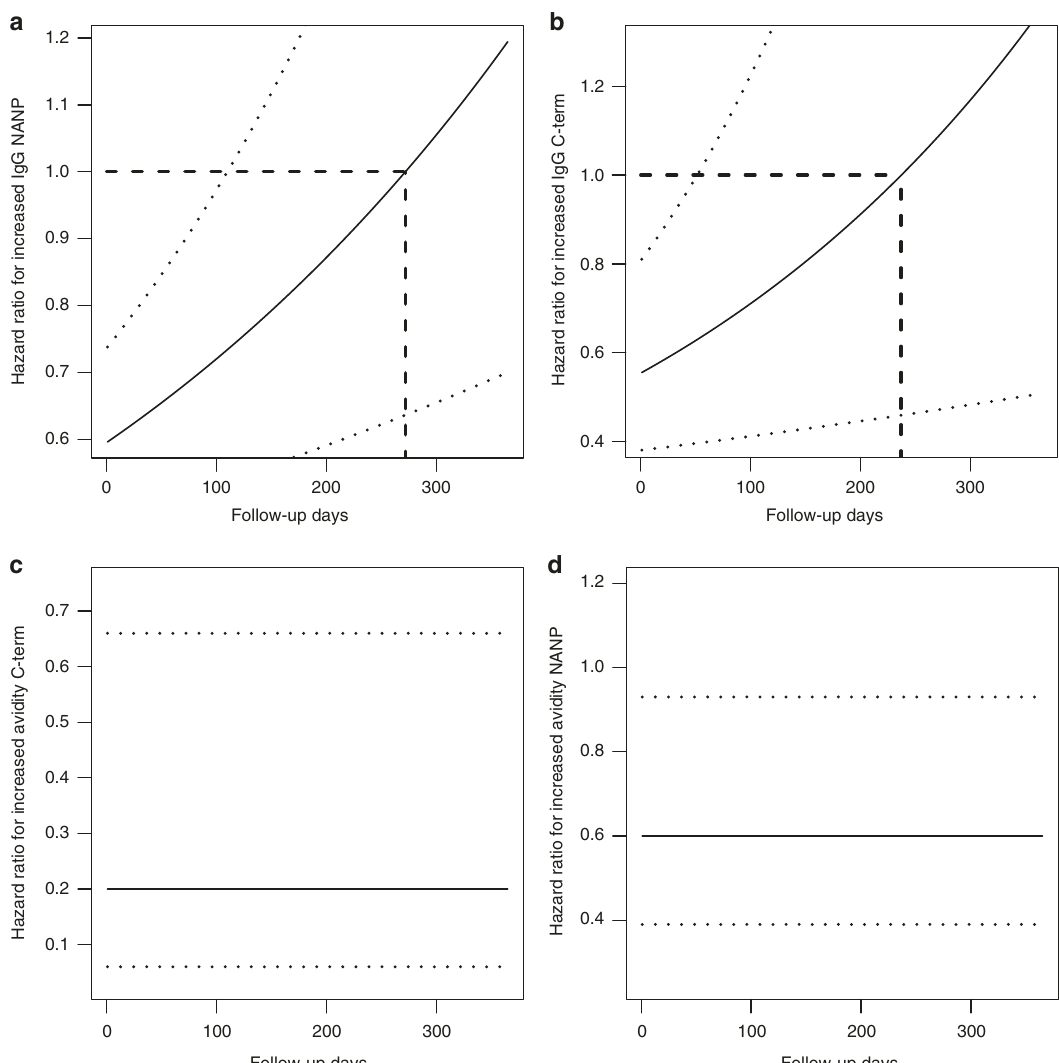
Fig. 5 Effect of CSP antibody concentration on protection against multiple malaria episodes. Association between continuous anti-CSP IgG responses and the hazard of recurrent clinical malaria events within a 12-month follow-up period. a One unit increase in IgG NANP protects from clinical malaria and is signi fi cant (95% con fi dence interval [CI] excludes 1) in RTS,S/AS01E vaccinees in the beginning of the follow-up period. As times progresses, increased NANP IgG is less protective and becomes not signi fi cant (95% CI includes 1) at approximately 120 post-vaccination days. b The hazard ratio (HR) of C-terminus (C-term) IgG and recurrent clinical malaria episodes is shown suggesting that increased C-term IgG is signi fi cantly protective from clinical malaria until day 90 in RTS,S/AS01E vaccinees. c Increased avidity index (AI) to NANP and, in d increased AI to C-term, is constantly and signi fi cantly associated with a lower risk of clinical malaria in RTS,S/AS01E vaccinees. HRs were estimated in a time-varying proportional hazard model with a HR exponentially varying over time ( p -value of Schonfeld residual tests for NANP and C-term IgG was <0.001, thus, rejecting a constant HR). Models for IgG concentrations and AIs also included study sites and age cohort